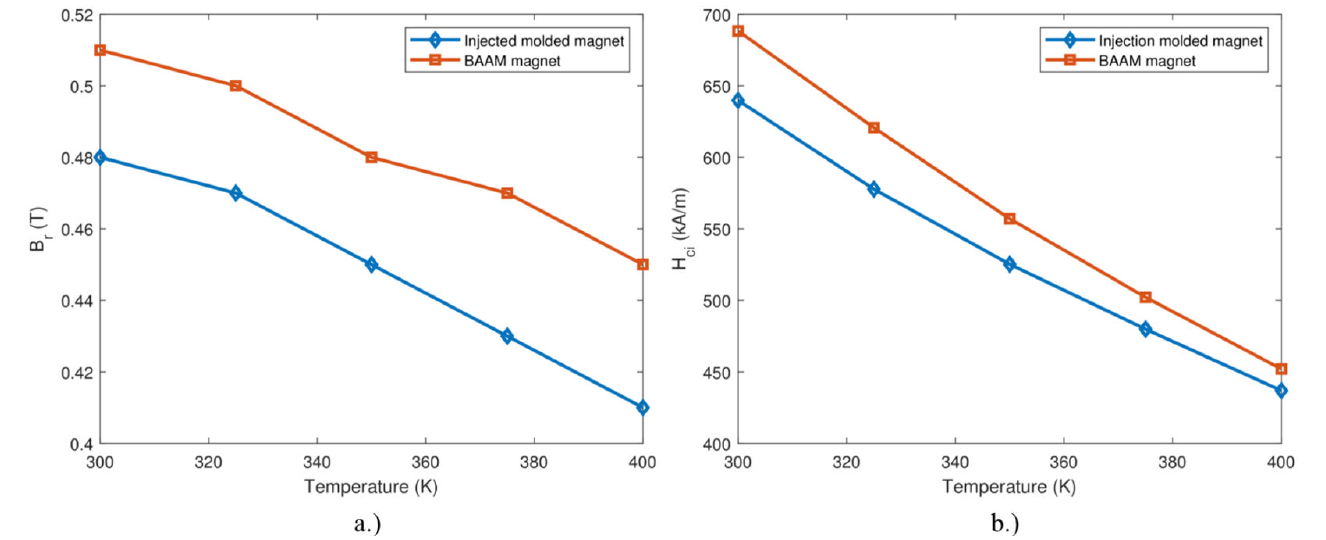
Figure 3. Comparison regarding the effect of thermal degradation on performance of conventional and AM-manufactured magnets ( a ) Remnant flux density as function of ambient temperature ( b ) Intrinsic coercive force as function of ambient temperature [24,45].